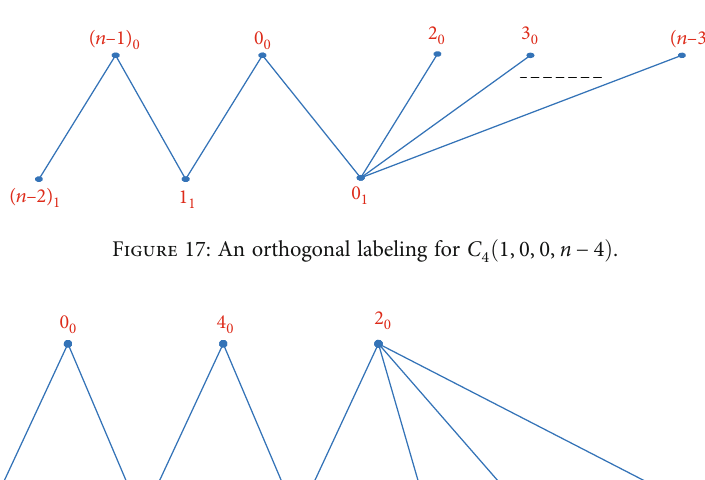
Figure 18: An orthogonal labeling for C